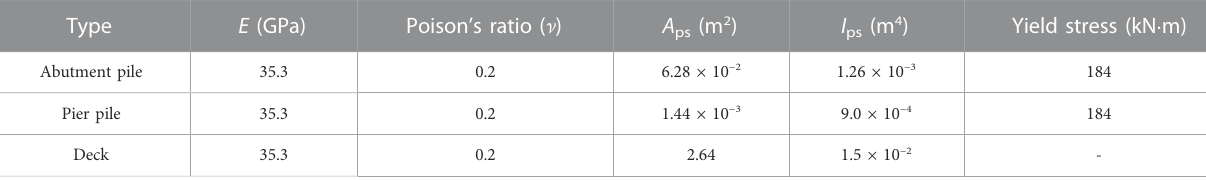
TABLE 1 Input parameters for the pile and the deck in the fi nite element